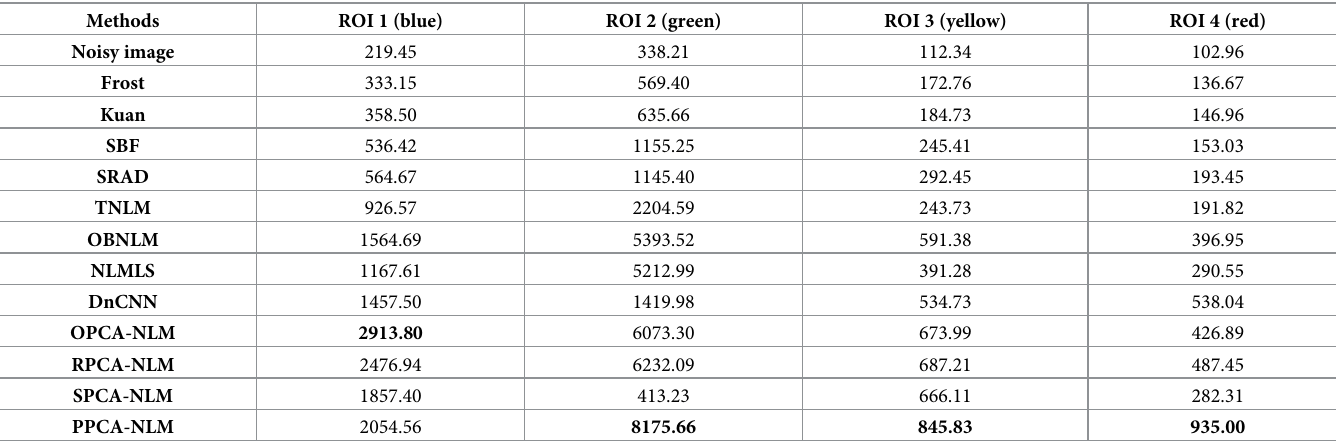
Table 5. The ENL values of four ROIs on a real ultrasound image. Methods